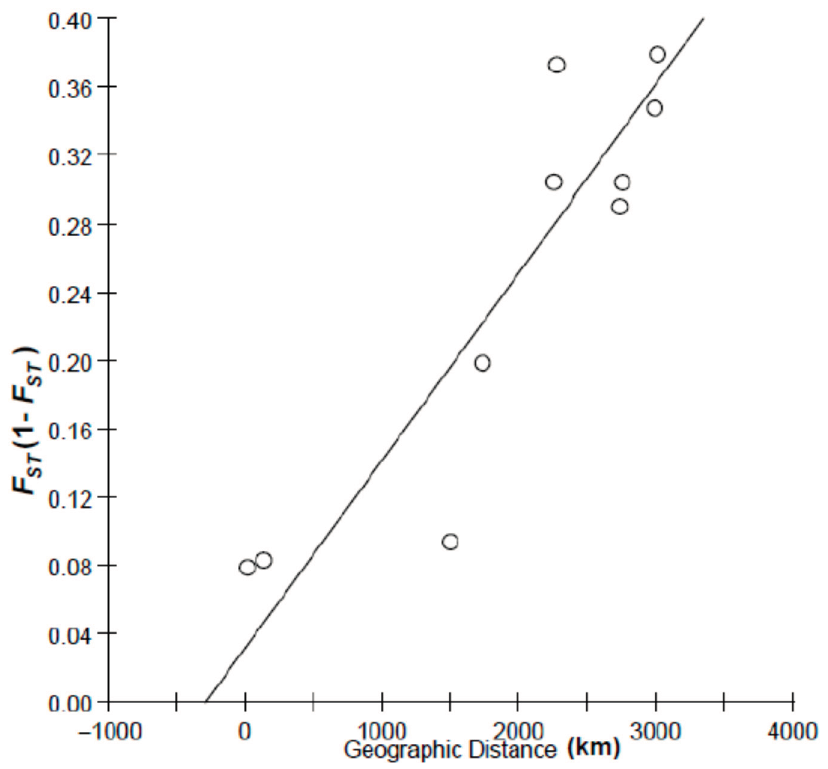
Figure 5. Plot of pairwise estimates of F ST /(1 − F ST ) vs. oceanic distance between